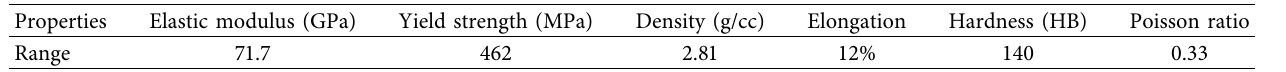
Table 2: ZrB 2 /AA 7475 MMCs mechanical and physical characteristics.